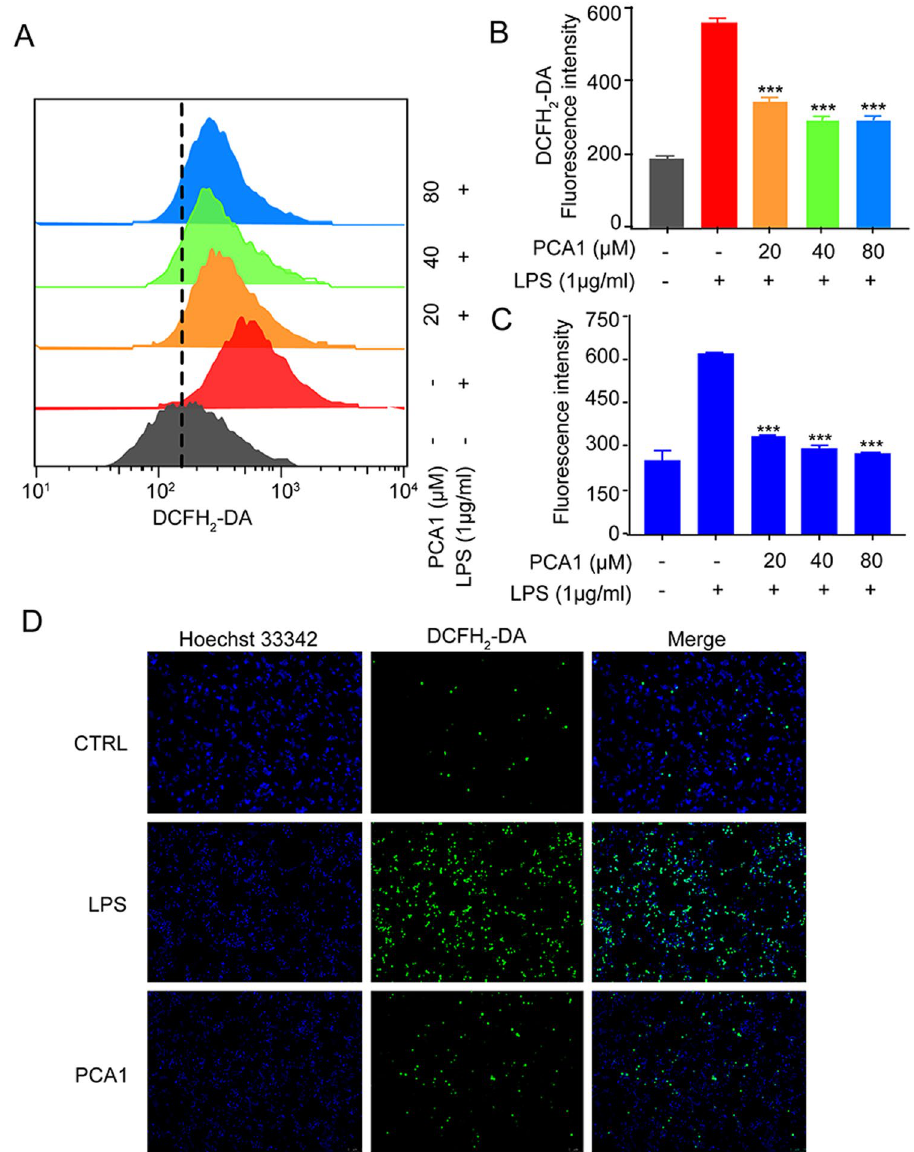
Figure 5. PCA1 inhibited ROS generation. ( A ) RAW264.7 cells treated with for PCA1 (20, 40, 80 μ M) for 1 h were incubated with LPS for 8 h. Cells were stained with DCFH 2 -DA (1 μ M) for 30 min. The fluorescence intensity was determined by flow cytometry at the FITC channel. ( B ) Statistical analysis of the ROS per group. ( C ) RAW264.7 cells were seeded into 96-well plates and cultured overnight. Cells pretreated with PCA1 (0, 20, 40, 80 μ M) for 1 h were stimulated with LPS (1 μ g/ml) for 8 h. The ROS level was determined by a ROS kit (Sigma MAK143) according to the manufacturer’s instructions. ( D ) ROS level in cells was stained with DCFH 2 -DA. The images were captured by fluorescence microscopy. *** p < 0.001 versus the LPS